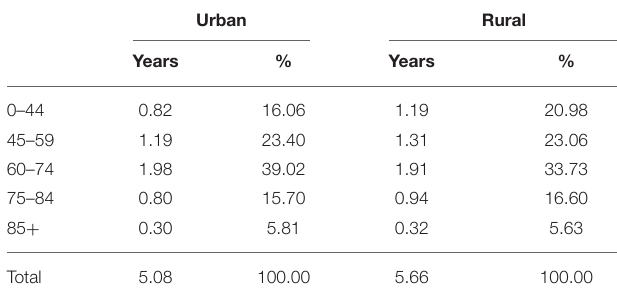
TABLE 2 | Age-specific contributions to the gender gap in life expectancy at birth during 2013–2018.